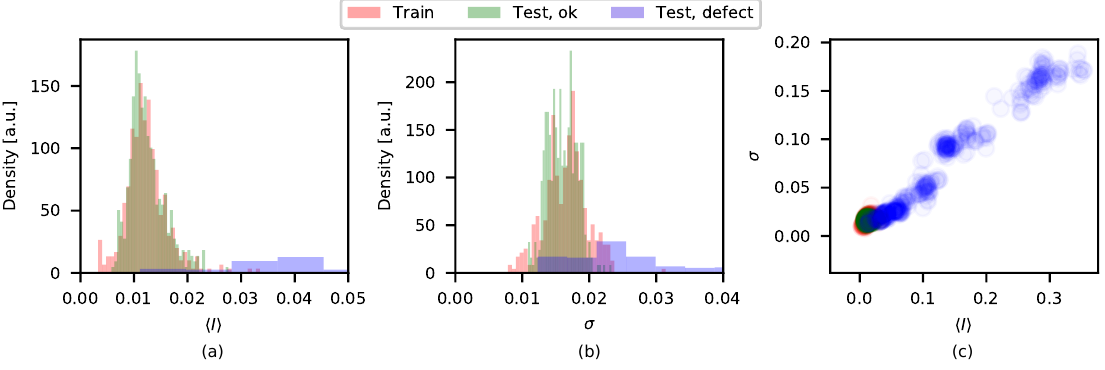
Figure 9. Residual image analysis results for the high contrast real defects test dataset. The (cid:104) I (cid:105) distribution is given in ( a ), the σ distribution in ( b ), and in ( c ) σ versus (cid:104) I (cid:105) is plotted. Observe that the histograms have different scales than the scatter plot.